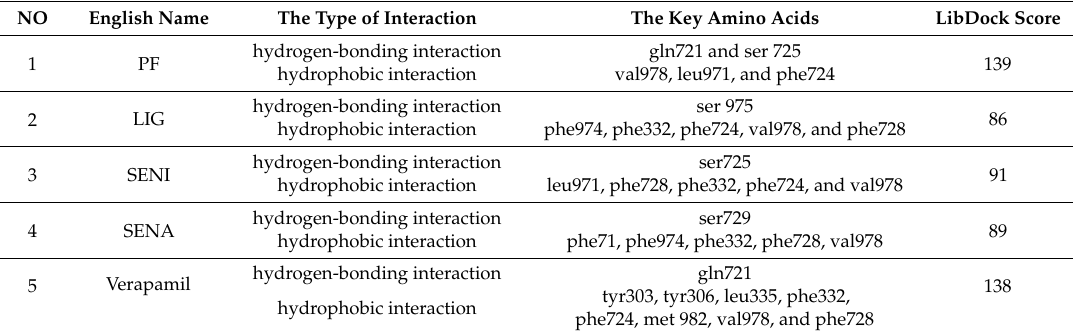
Table 4. The detailed binding modes of ligands with P-gp and the LibDock Socre.